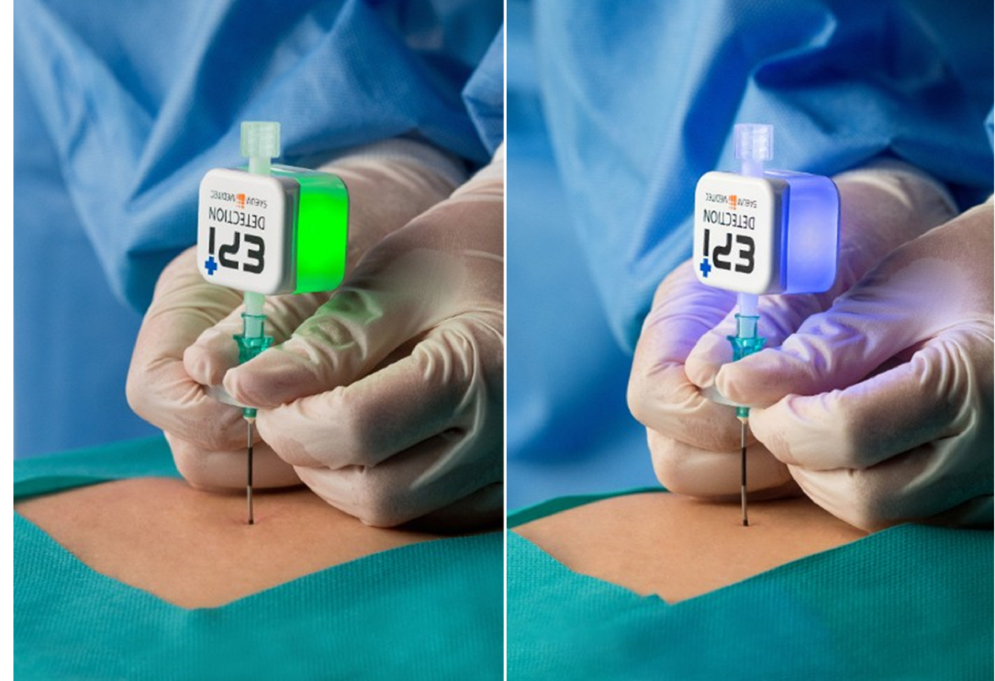
Figure 3. In the ready-on state, the LED glows green. As the needle advances and reaches the epidural space, the LED turns blue and produces a beep sound. space, the LED turns blue and produces a beep